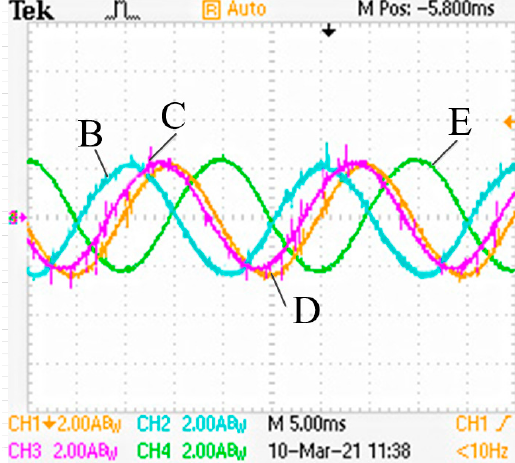
Processes 2022 , 10 , 1891 Figure 12. Lack of phase A fault − tolerant current waveform. Figure 12. Lack of phase A fault − tolerant current waveform. Figure 12. Lack of phase A fault-tolerant current waveform.